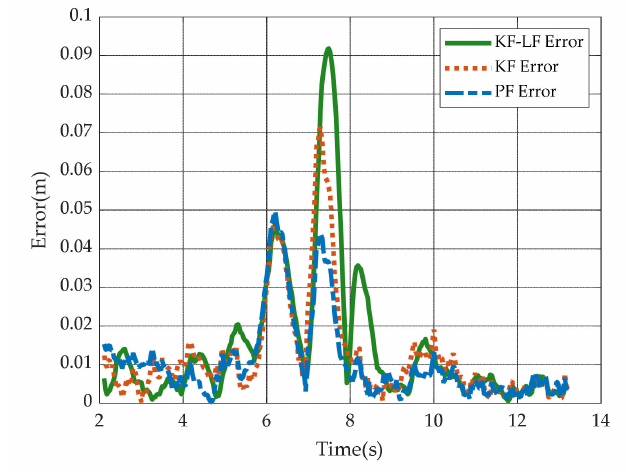
Figure 15. Prediction error curve of the three filters. Table 2. Mean square error (MSE) of the filters.